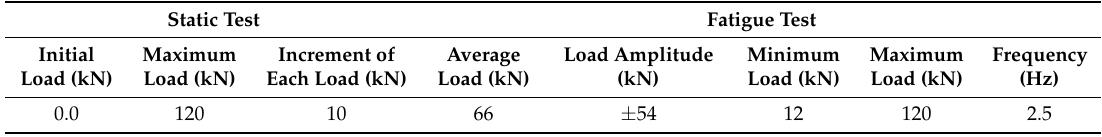
Table 3. The experimental program.